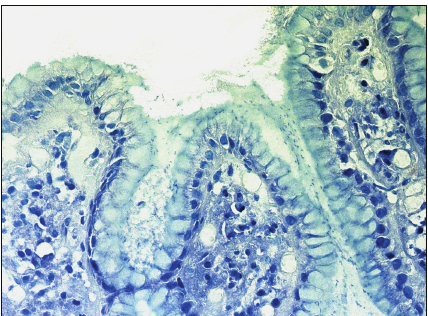
Figure 1: Antrum mucosa in H. pylori -associated gastritis: mucus masses with H. pylori agglomerations on mucosa surface, Giemsa staining, magnitude × 200.